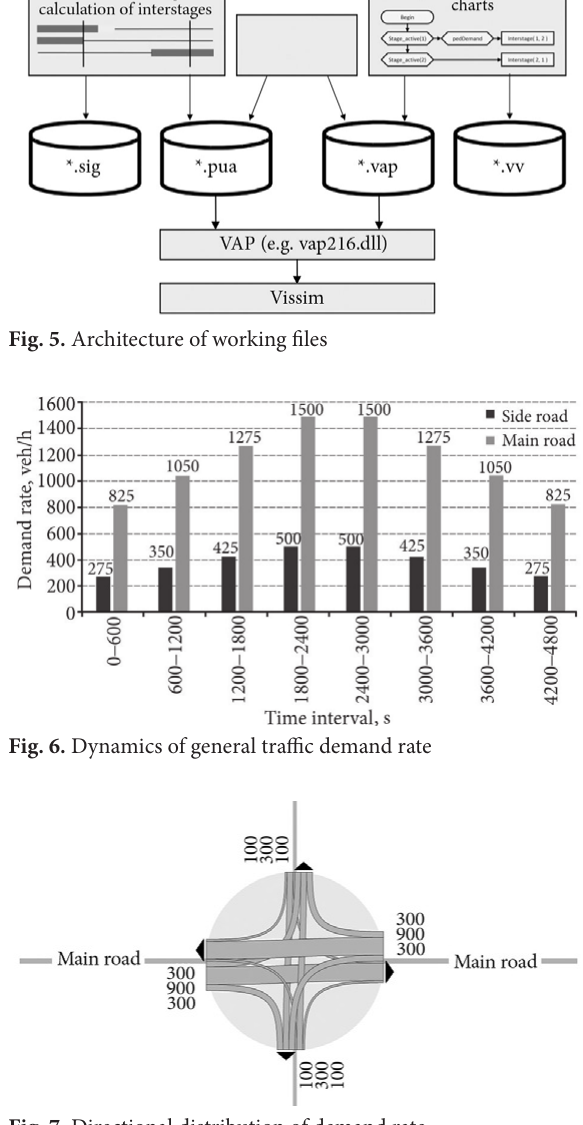
Fig. 7. Directional distribution of demand